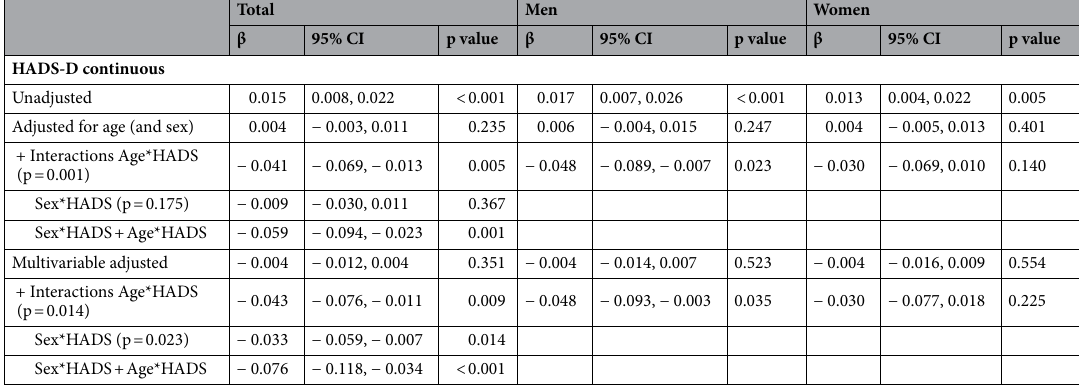
Table 4. Linear regression models for ACR as continuous dependent variable, according to HADS-D as a continuous score. Mulitvariable adjusted for age, sex (in the total population), systolic blood pressure, waist circumference, cholesterol, creatinine, cardiovascular disease, daily smoking cigarettes, treated hypertension, diabetes, education, and hard physical activity, and with the interaction terms age*HADS-D and sex*HADS-D (total sample). ACR albumin/creatinine ratio.